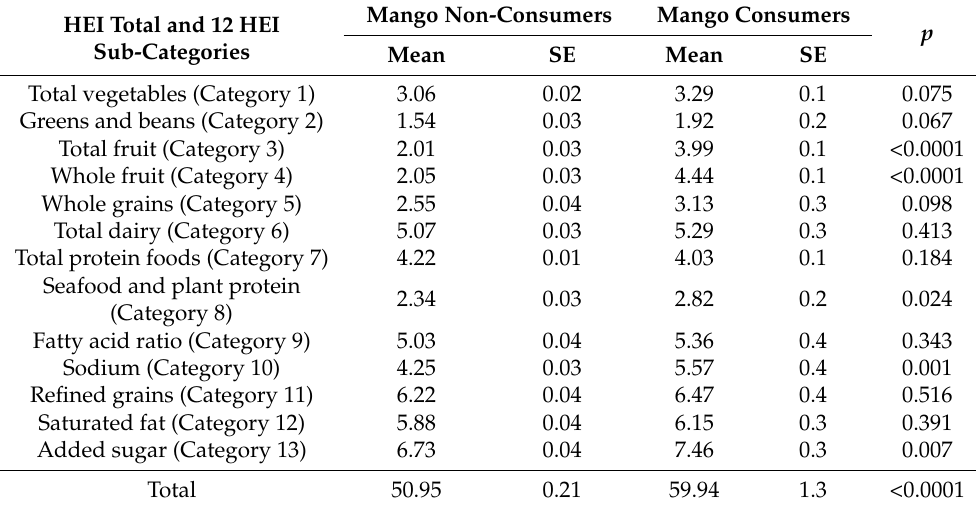
Table 5. Day 1 Healthy Eating Index (HEI)-2015 and sub-category mean scores in